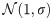
The role of N2, P and D on the desynchronisation for the PDF-control.The average Kuramoto order parameter 〈R(t)〈 is reported as a function of number of controlled oscillators, N2, and the control strength, P, for D = 10. For each couple (N2, P) ∈ [5, 50] × [2, 40], we numerically simulate the PDF-controlled system on the KM involving N = 100 oscillators coupled using an all-to-all scheme; each point being the average of 25 independent realisations. The coupling parameter is K = 0.5 and the natural frequencies are drawn from a normal distribution N(1,σ), σ = 0.01 and the initial angles uniformly randomly drawn in [0, 2π].